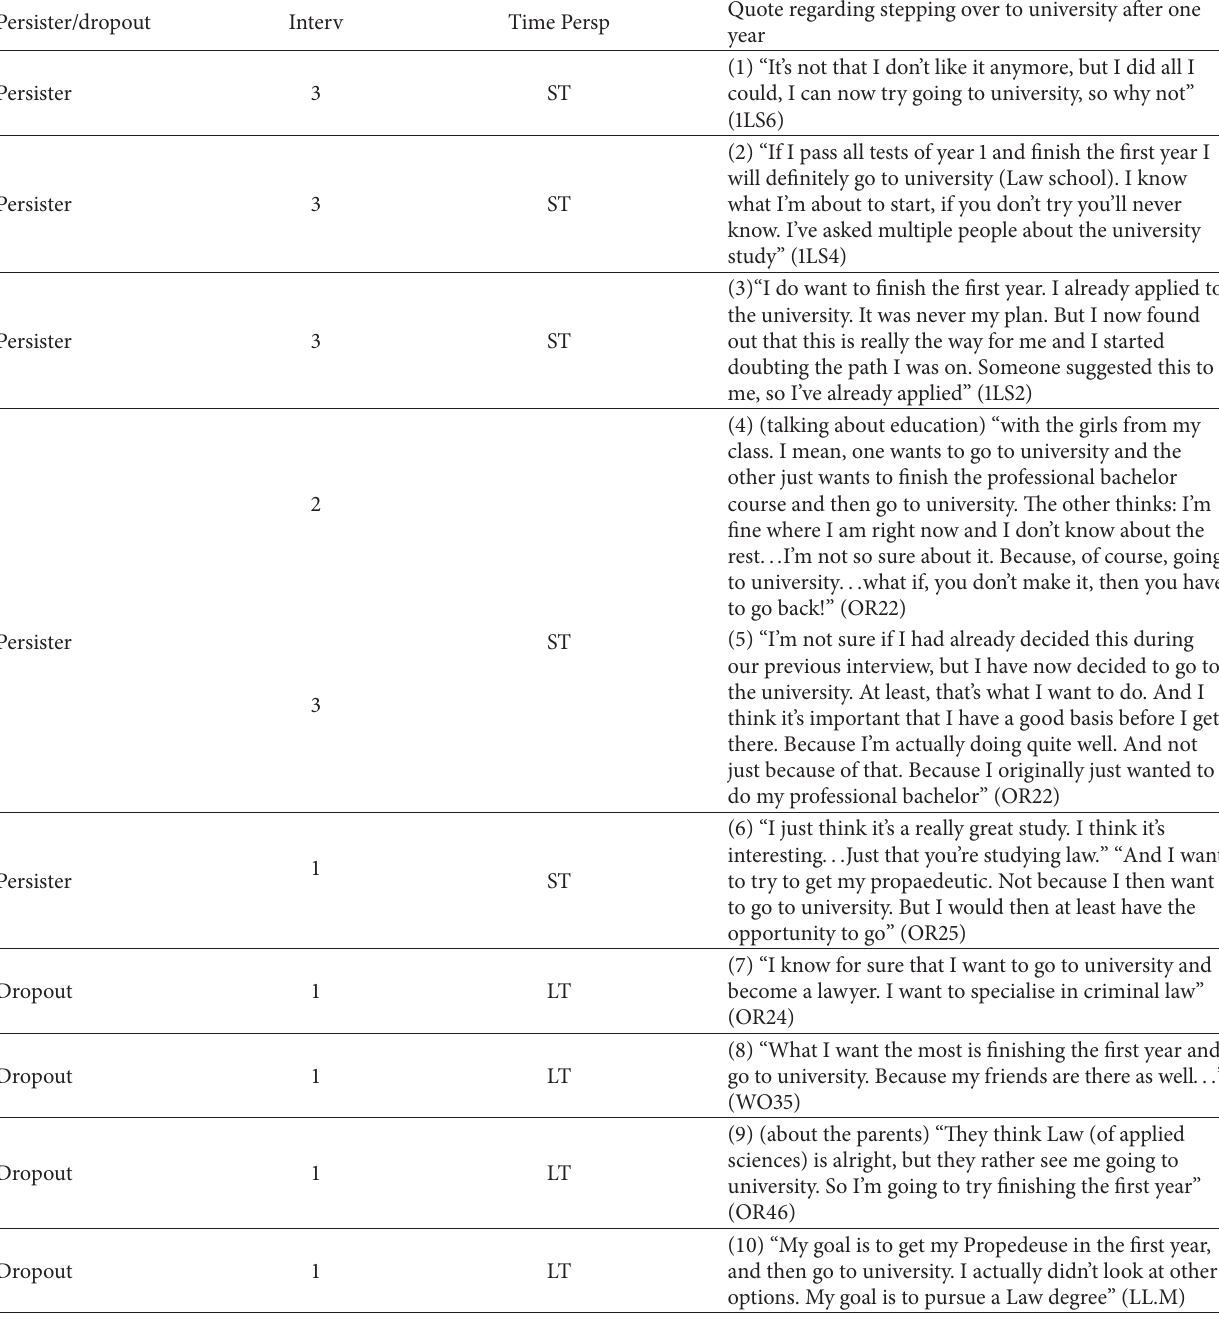
Table 11: Quotes that illustrate the developing ambition throughout the academic year to switch to the university versus participants wishing to switch to the university from the very beginning of the academic